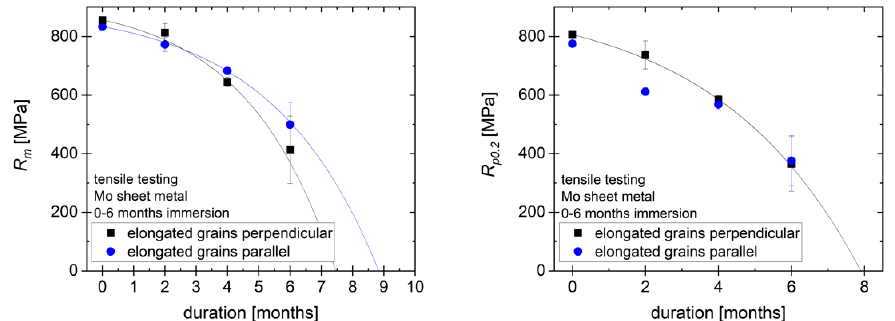
Figure 9. Tensile strength and yield strength of molybdenum sheet metal.